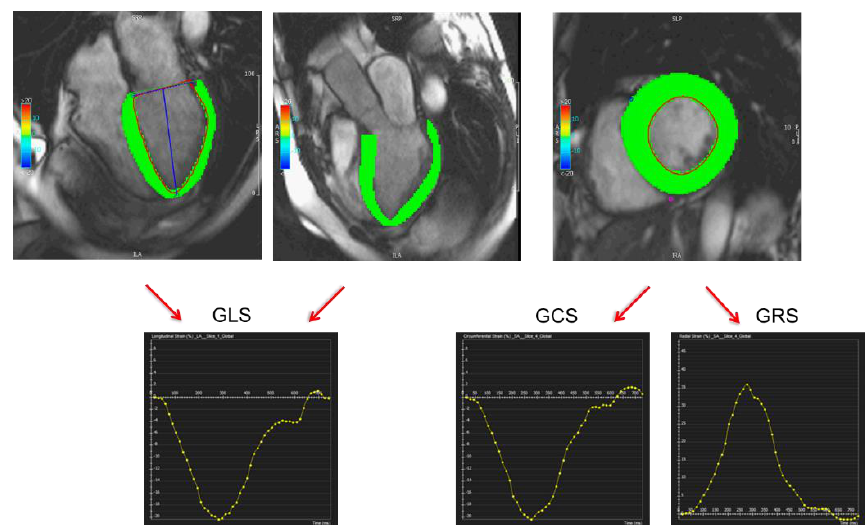
Figure 7. Myocardial strain calculation from cardiac magnetic resonance cine images using feature tracking analysis (post-processing with CVi42, Circle Cardiovascular Imaging Inc., Calgary, AB, Canada).